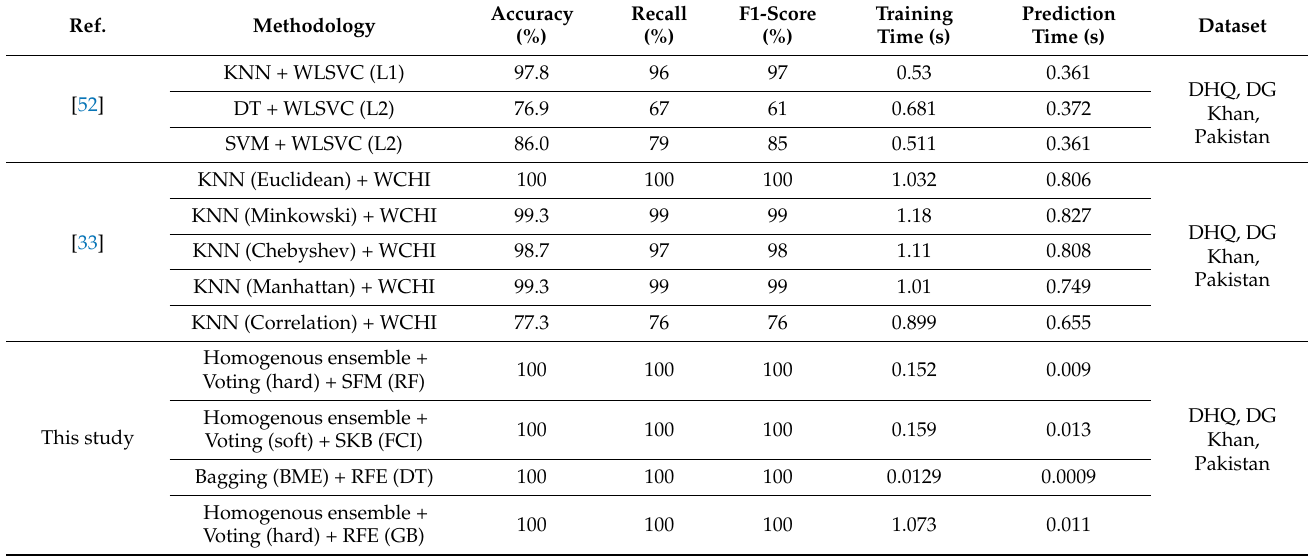
Table 7. The comparison of the performance evaluation metrics and computational cost of the proposed research methodol- ogy with existing